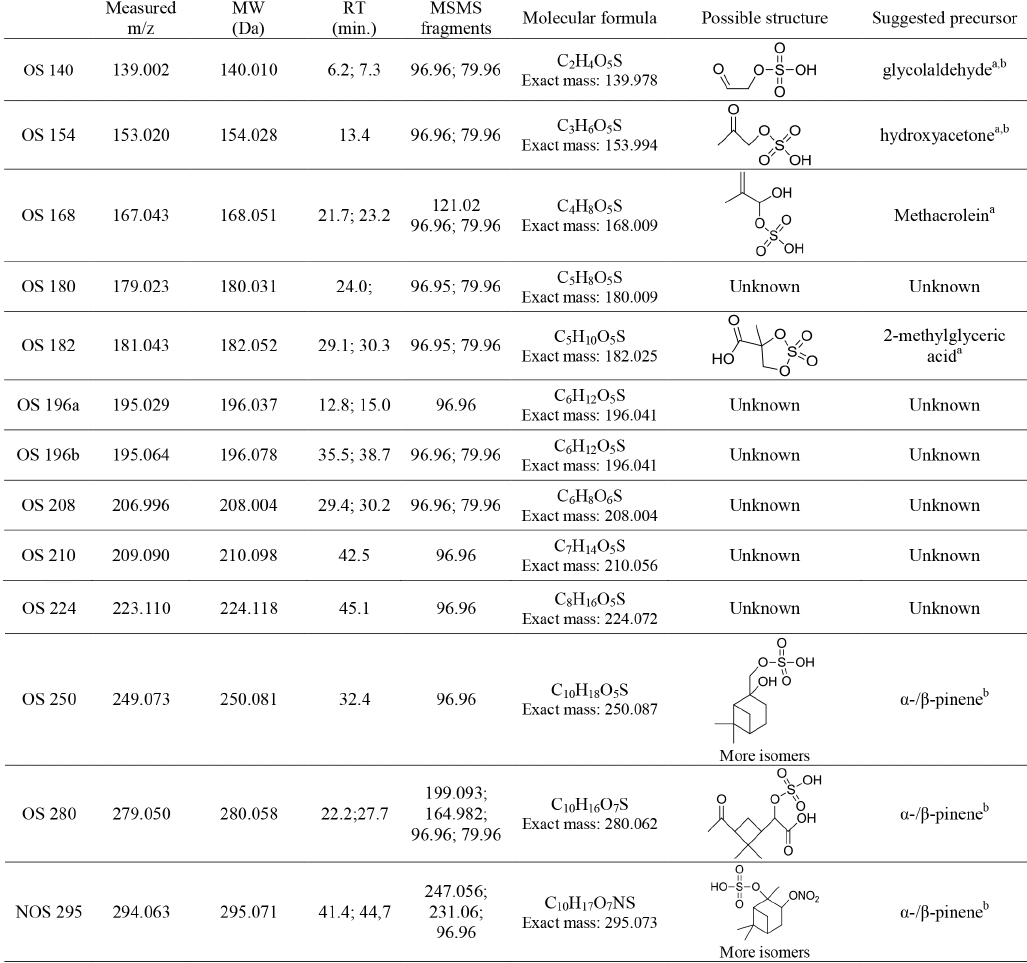
Table 1. The observed organosulfates and nitrooxy organosulfates. Measured m/z , molecular weight, retention time, MSMS